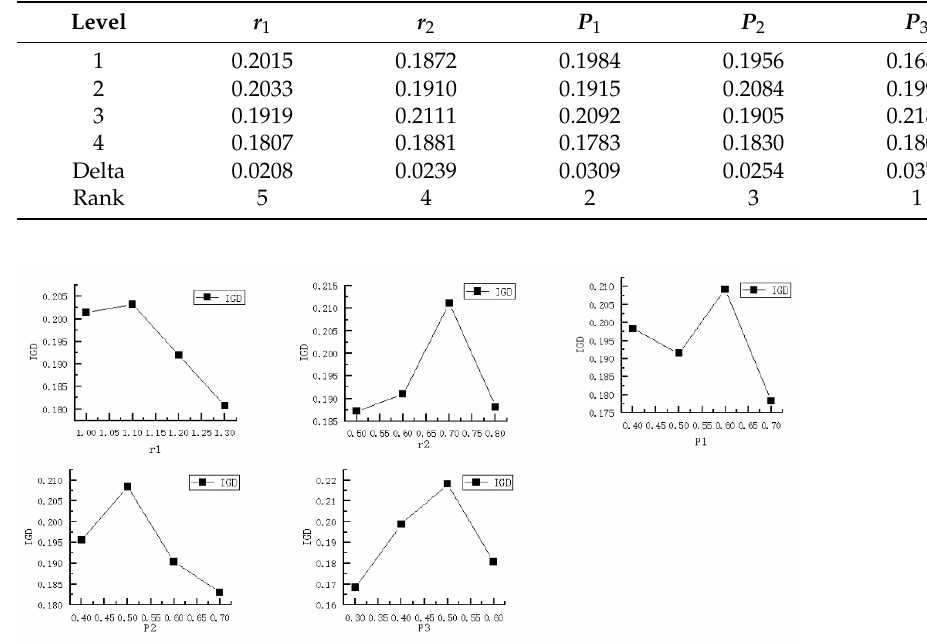
Figure 9. Factor level trend of the parameters.